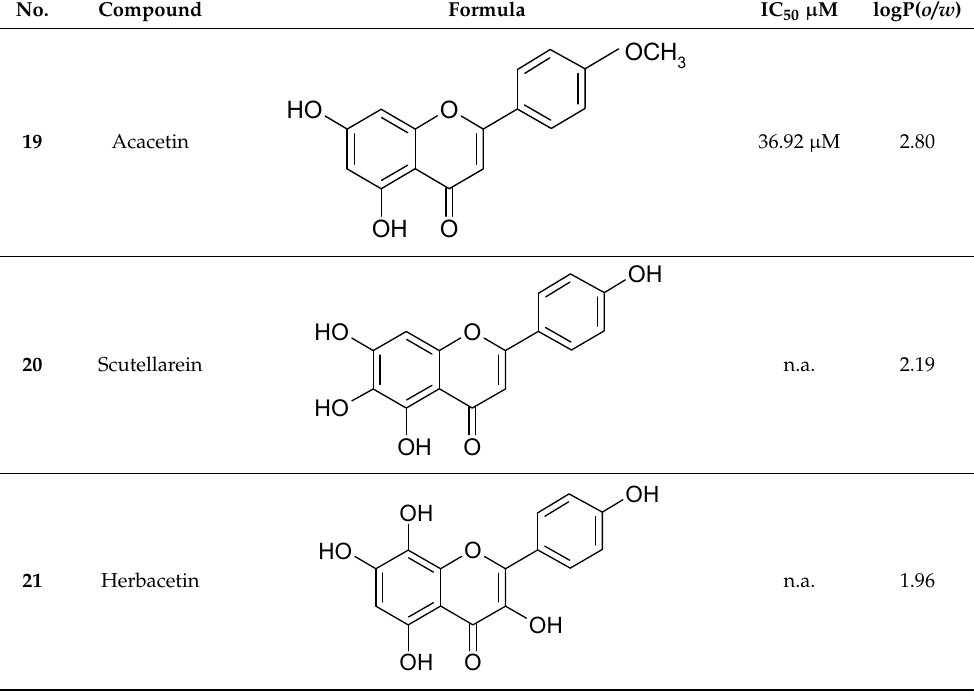
Table 2. Compounds tested in the CCID assay (MCF-7 spheroids on LECs) as a proof of concept, the respective IC 50 ( μ M) and calculated logP (o/w) values.